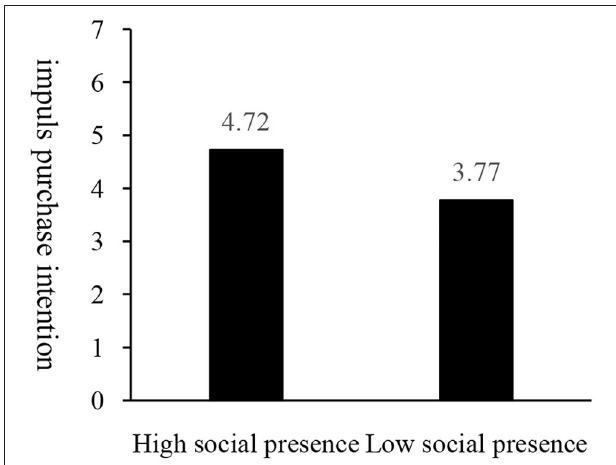
FIGURE 4 | Impact of social presence on impulse purchase